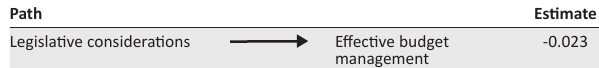
TABLE 14: Legislation consideration (Hypothesis